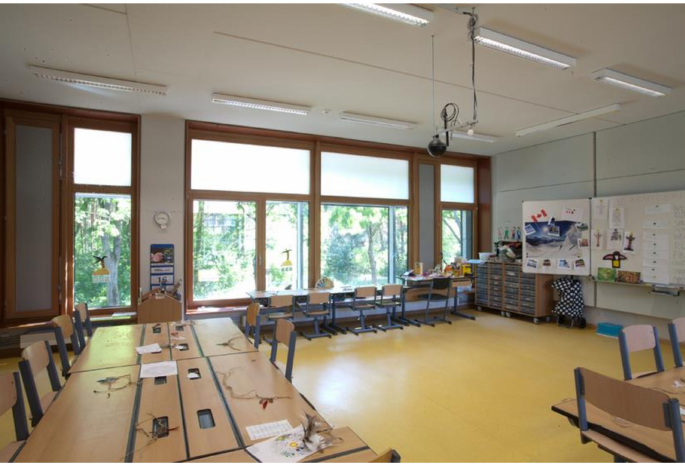
Figure 5. Classroom (Supplementary